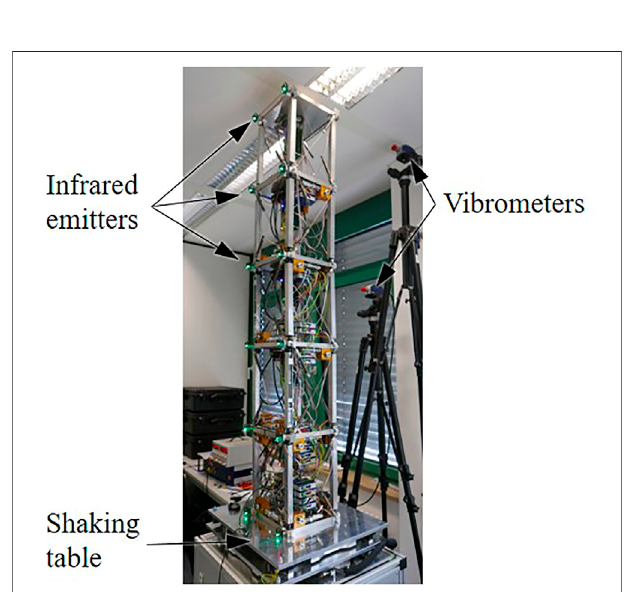
FIGURE 9 | 1:18-Scale model. Optical measuring system and two vibrometers to validate the estimated displacement (Source: ISYS).